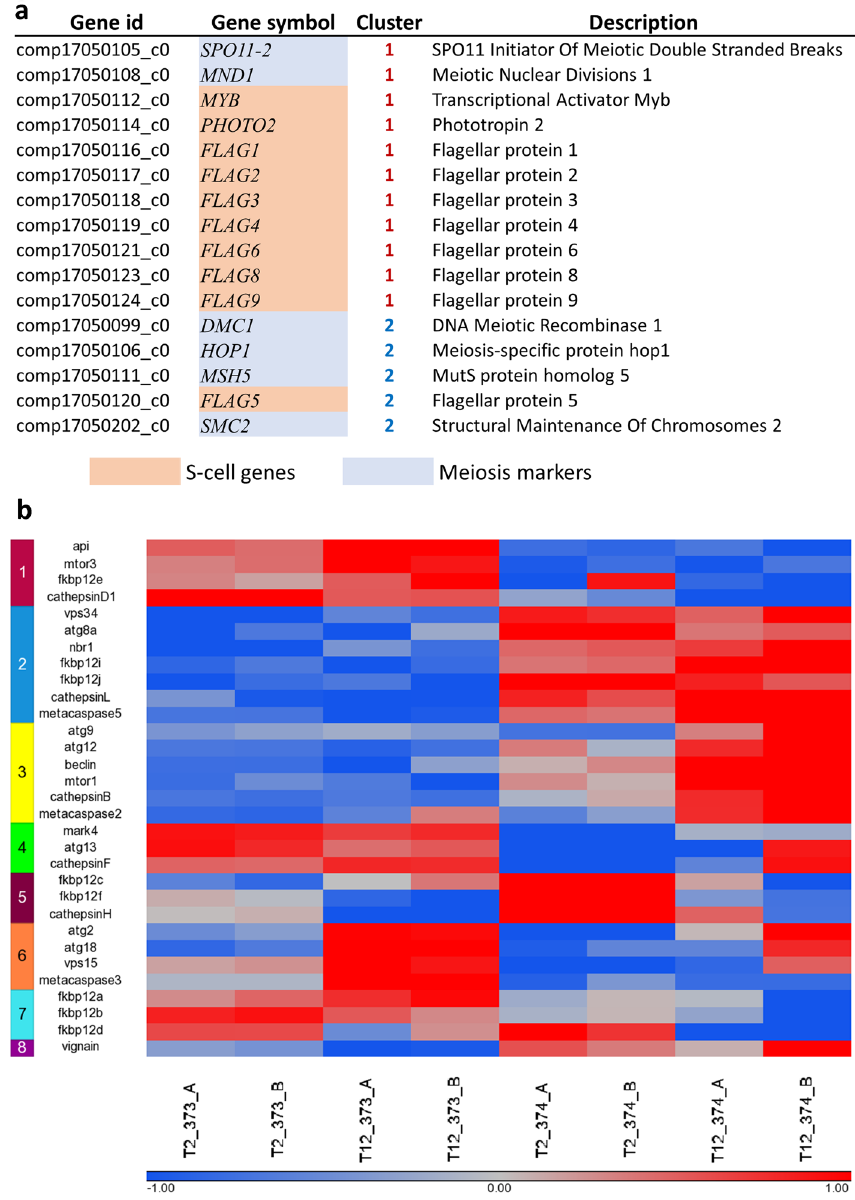
Figure 6. Examples of specific gene sets. ( a ) S-cell and meiosis genes that were identified in clusters 1 and 2, S-cell genes are enriched in cluster 1 and meiosis genes are enriched in cluster 2 ( b ) Genes related to autophagy and cell death, as they appeared in the K-mean clustering in Fig.